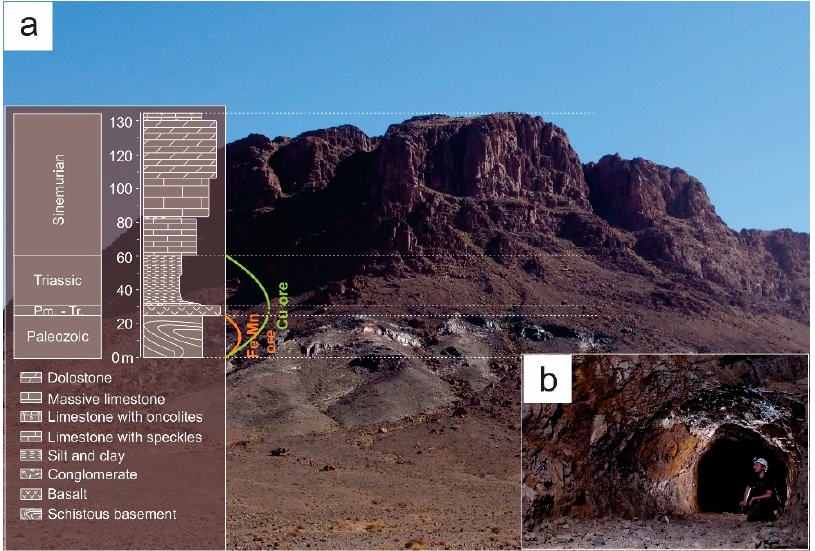
Figure 2. ( a ) Field view of Jbel Rhals and stratigraphic log of the observed units (modified after [3]); ( b ) mining gallery showing Fe-Mn mineralization.